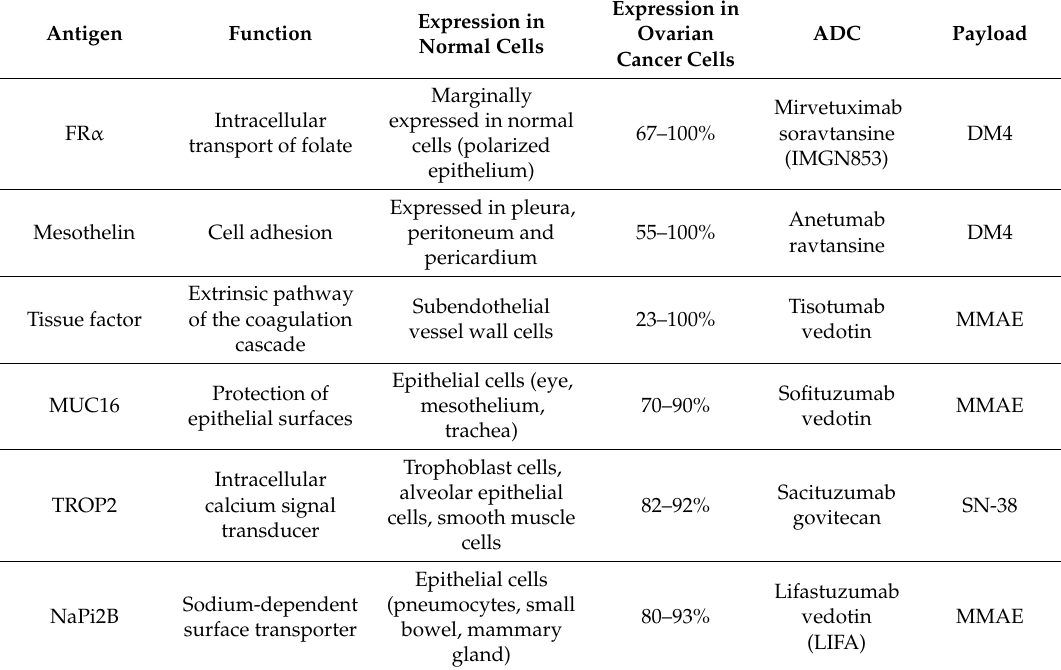
Table 2. Main characteristics of ADC antigens for treating ovarian cancer.